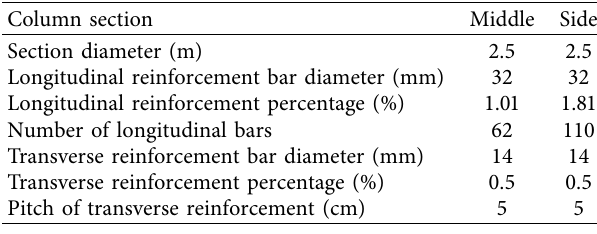
Table 1: Middle and side column properties.